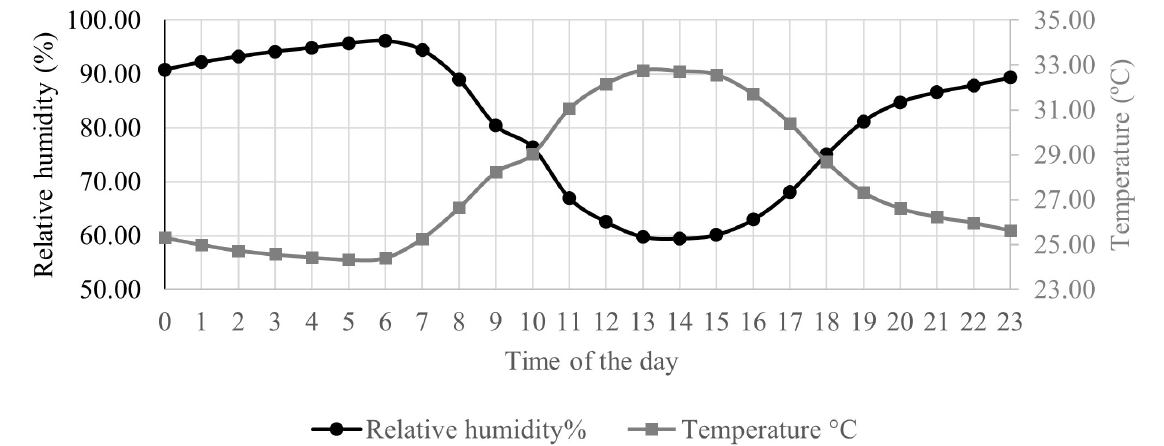
Figure 1. Relative humidity and temperature on the farrowing room for 24h of the day during the trial